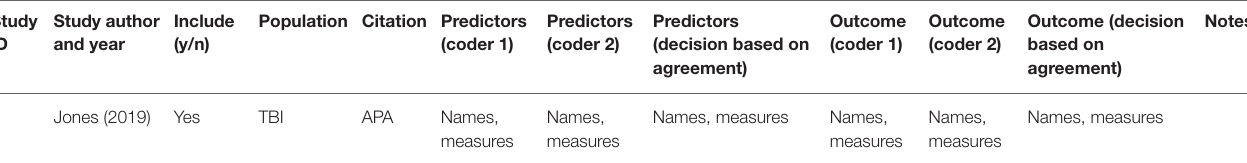
TABLE 1 | Process of cataloging studies and